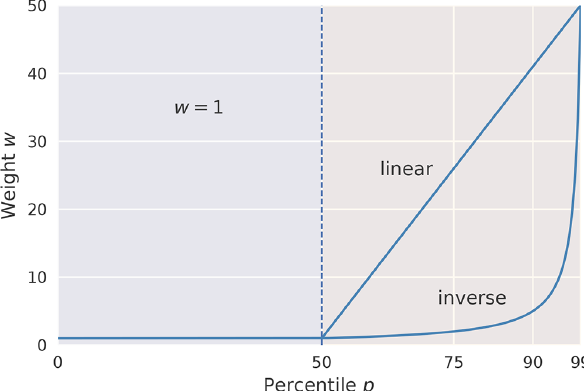
Figure 4. Weighting functions used to construct either the in- versely weighted mean squared error (W-MSE inv ) and mean abso- lute error (W-MAE inv ) or the linearly weighted mean squared error (W-MSE lin ) and mean absolute error (W-MAE lin